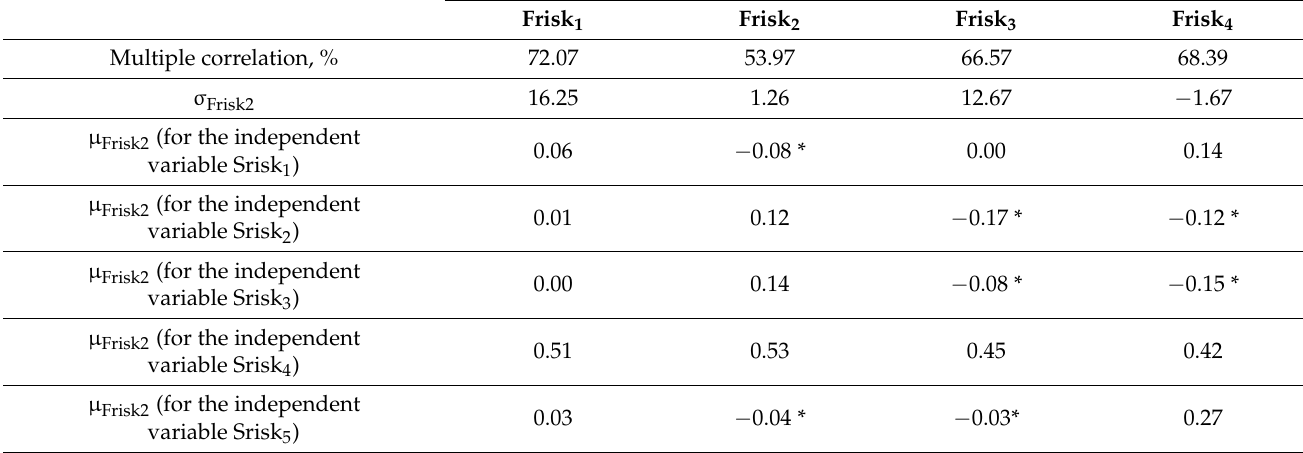
Table 8. Dependence of the financial consequences (Frisk) on social consequences of investments in innovation